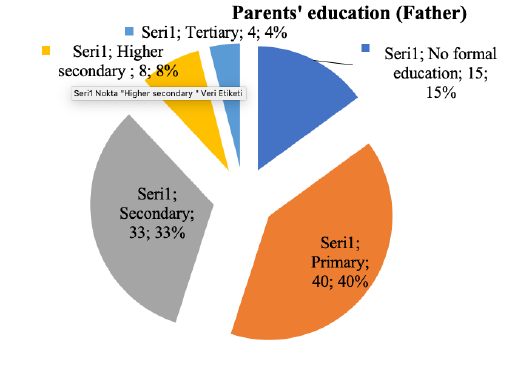
Figure 3: Parent’s Education (Father)